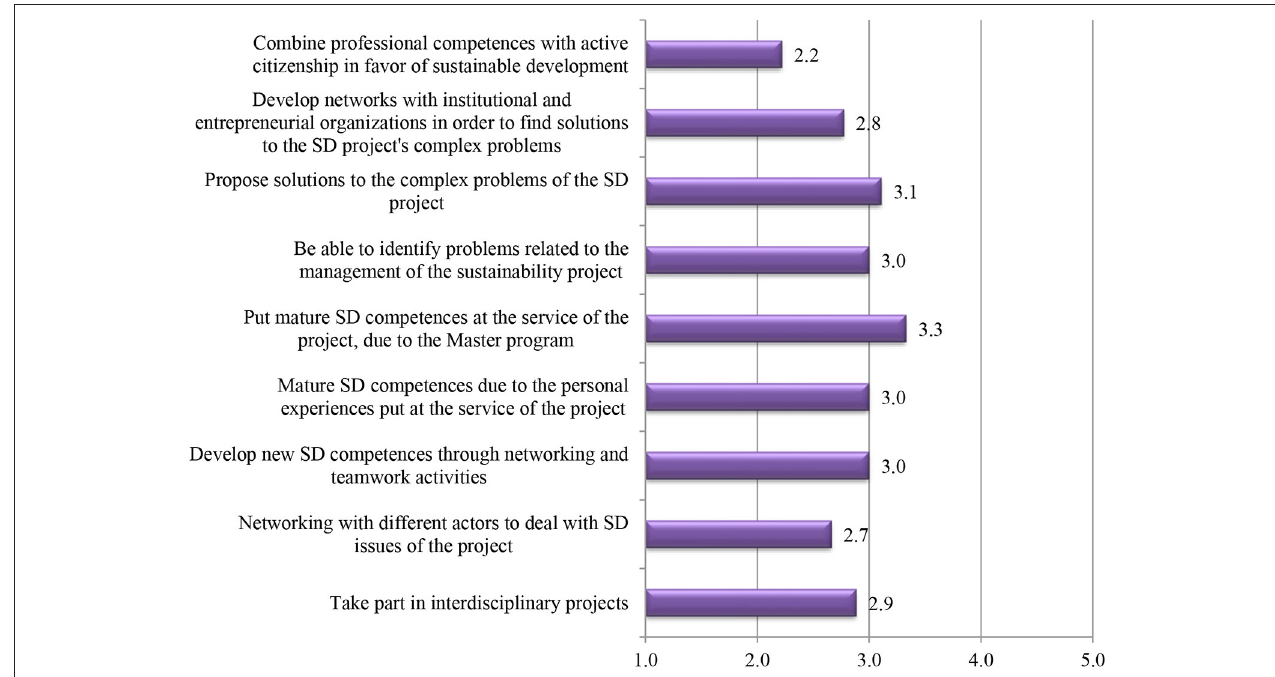
FIGURE 4 | SD competences developed through and applied in the job